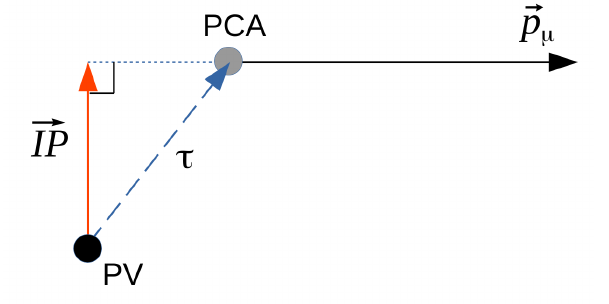
Figure 2. Schematic representation of the impact parameter. The tau lepton direction of flight is represented by a blue dashed line, while the charged prong momentum and the corresponding impact parameter are represented as full lines in red and black